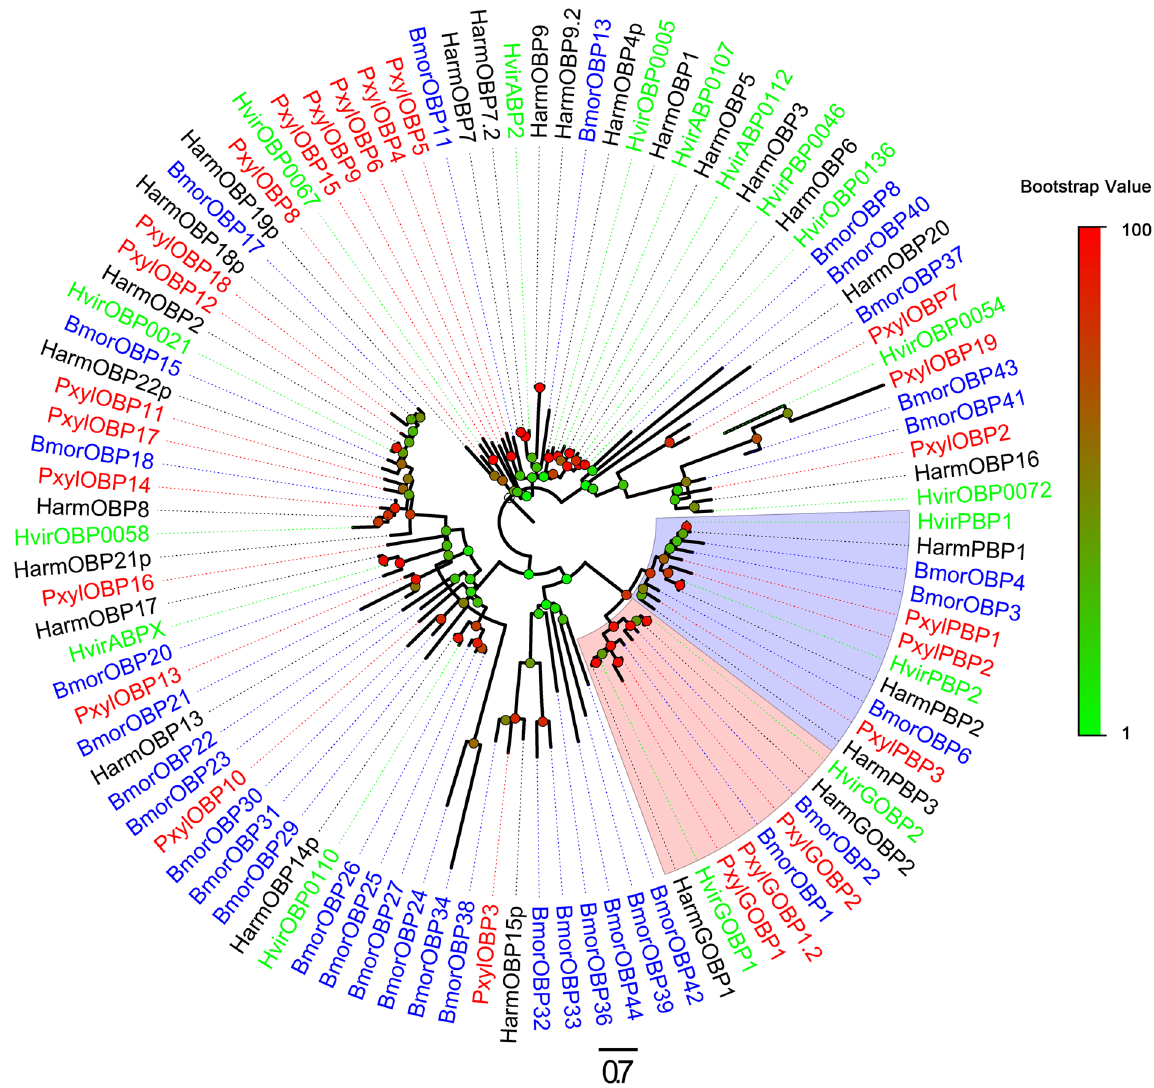
Figure 3. Phylogenetic tree of candidate Lepidopteran OBPs, including the GOBP and PBP clades. Pxyl: Pluttela xylostella (red), Harm: Helicoverpa armigera (black), Hvir: Heliothis virescens (green), Bmor: Bombyx mori (blue). The clade shaded in blue indicates the PBP clade. The clade shaded in red indicates the GOBP clade. The bootstrap value for phylogenetic tree construction is